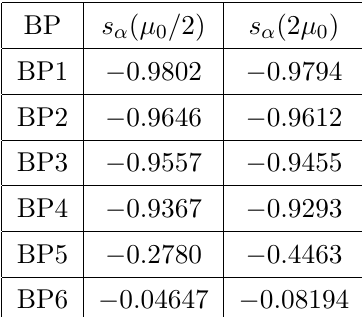
8 (see table 4) (cid:25) 0. (cid:25)